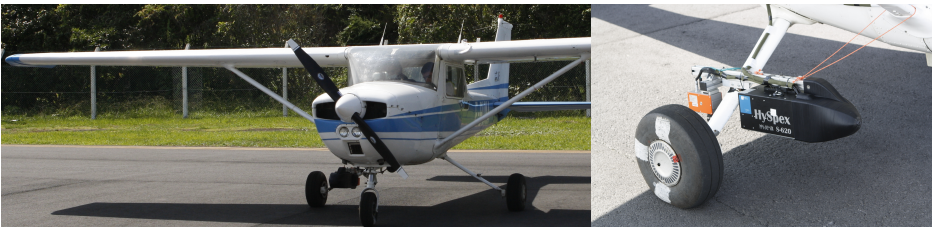
Figure 5. On the left -hand side image, the F-BUMA aircraft, and on the right side of the image, the hyperspectral imaging payload installation on aircraft landing gear.